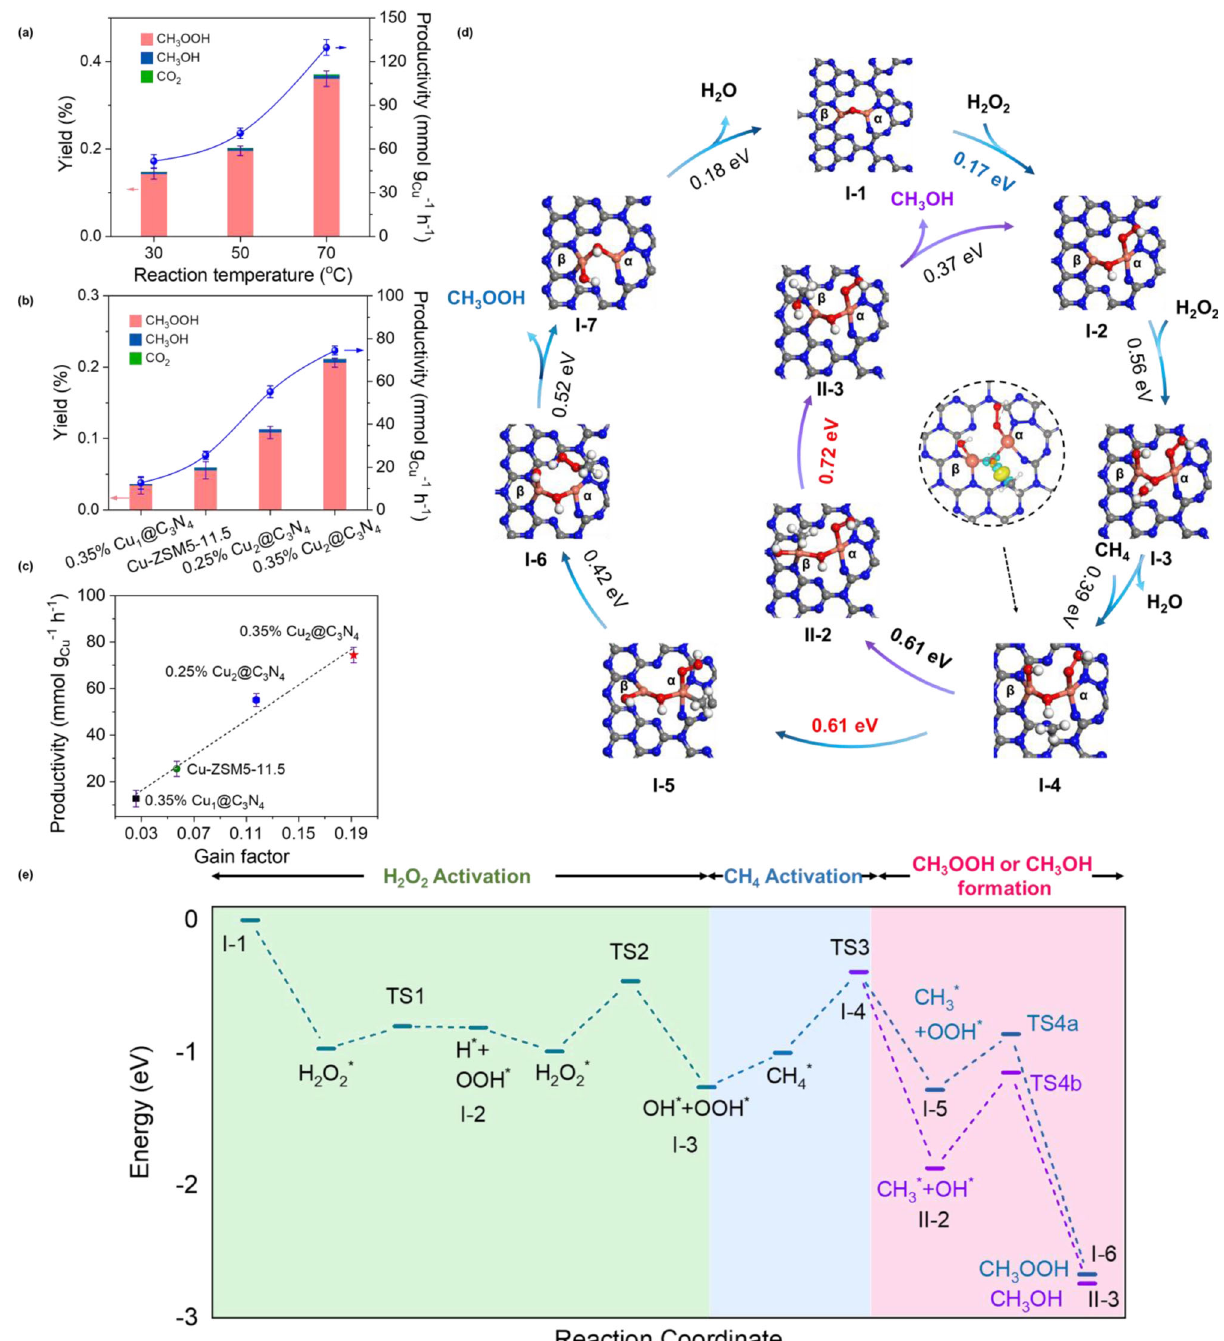
Fig. 3 Thermo-catalytic oxidation of CH 4 with H 2 O 2 . a Yields and productivity of methyl oxygenates at different reaction temperatures. b Comparisons of product yields and productivity over different catalysts. c Correlation between productivity of methyl oxygenates and gain factor for different catalysts. d Simulated pathways for the reaction between CH 4 with H 2 O 2 on the Cu 2 @C 3 N 4 catalysts, with the middle inset illustrating the electron distribution of the CH 4 molecule being activated on the bridging oxygen site. Energy barriers are also given for the associated molecular transformations. e The DFT calculated free energy diagram for the Cu 2 @C 3 N 4 -catalyzed partial oxidation of CH 4 with H 2 O 2 . Three stages consisting of H 2 O 2 activation, CH 4 activation and methyl oxygenates formation are distinguished with different colors. The error bars presented in ( a – c ) indicate the statistical distribution derived from three independent